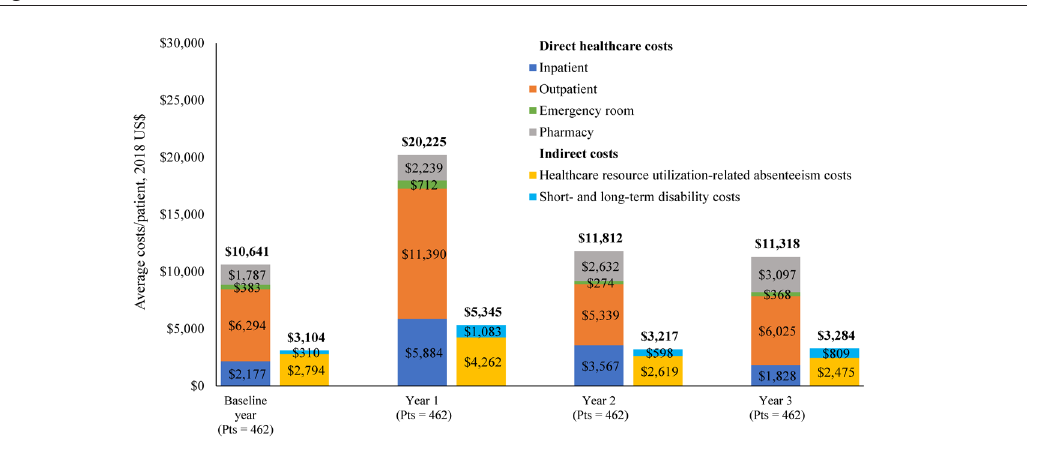
Figure 3. All-Cause Direct Healthcare Costs and Indirect